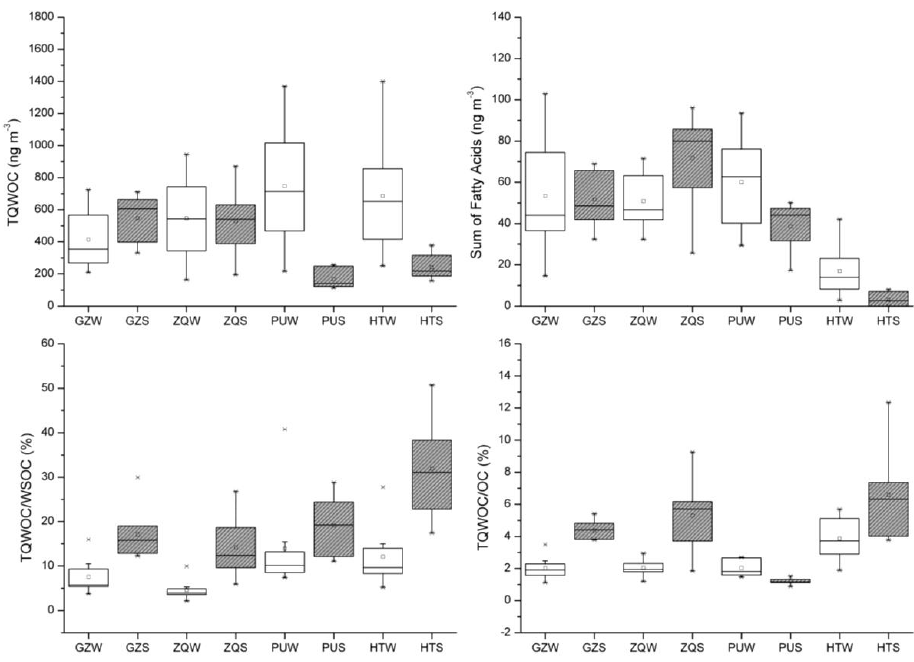
Fig. 3. Box plots of TQWOC and sum of fatty acid concentrations (ngm − 3 ) as well as TQWOC/WSOC and TQWOC/OC ratios in PM 2 . 5 samples during winter and summer in four cities in PRDR.